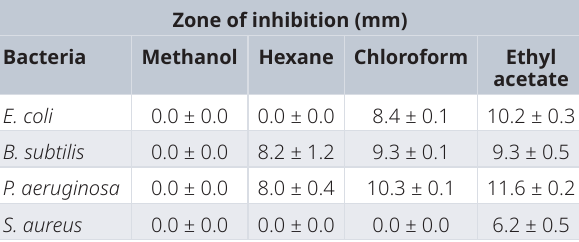
Table 1. Radical scavenging activities (RSA) and quercetin equivalent (QE) concentrations of V. pinnata